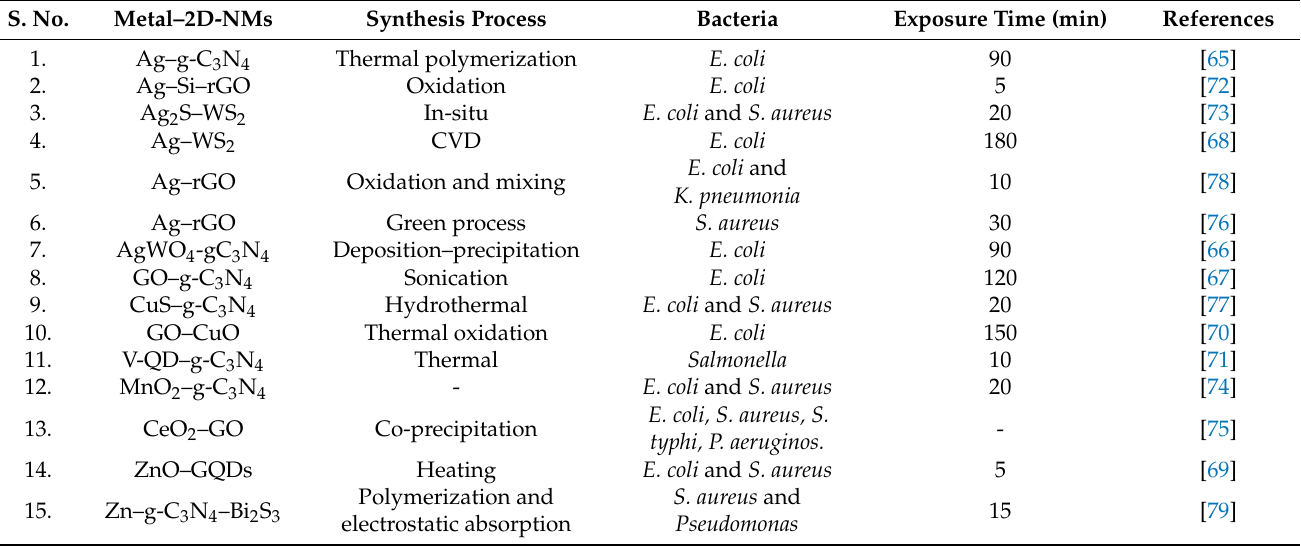
Table 2. Metal-doped 2D-NMs and their photo-antibacterial